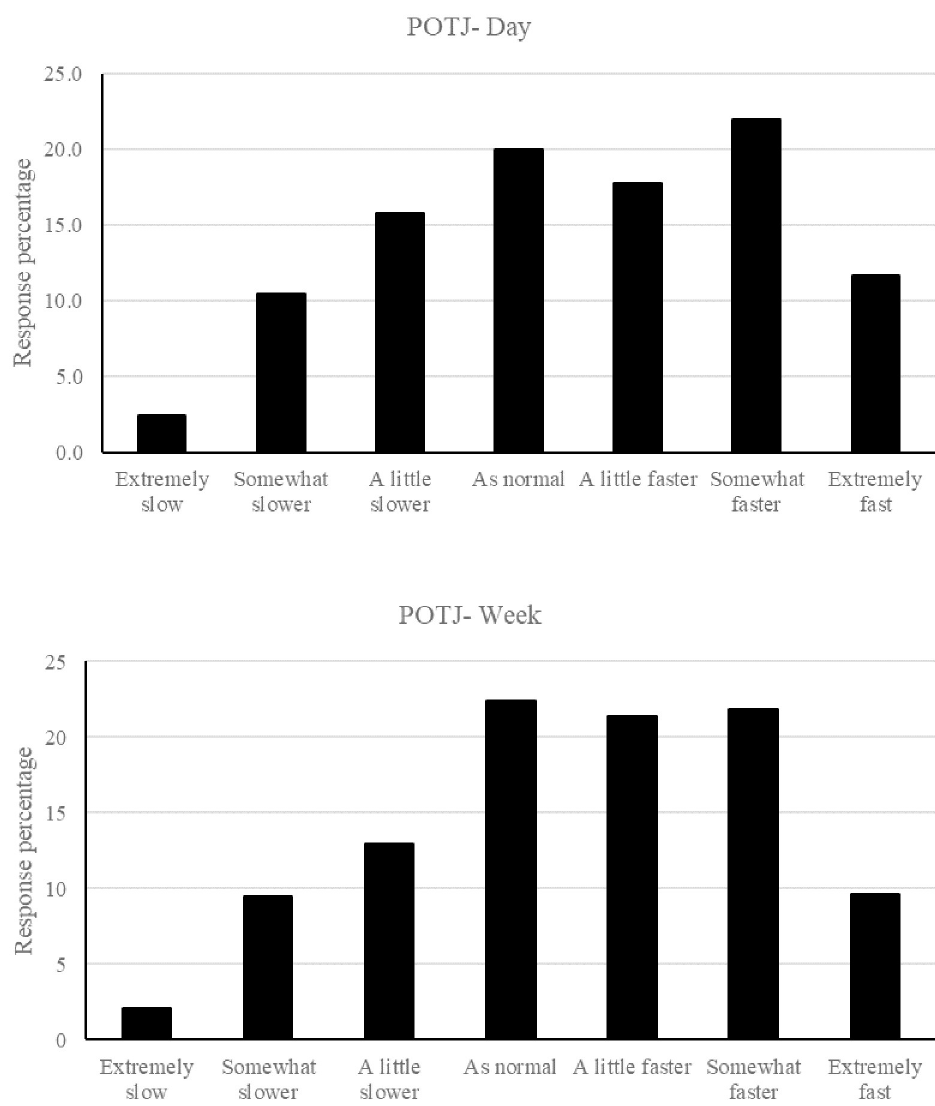
Fig 1. The frequency of responses for each Likert point for the day passage of time judgement (upper panel) and week passage of time judgment (lower